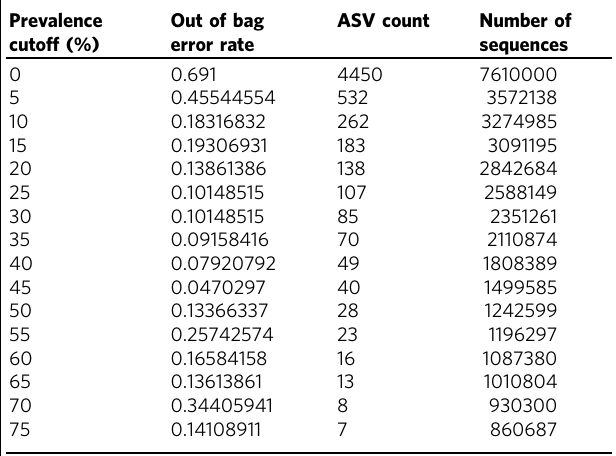
Table 3 Prevalence fi ltering focuses analysis on most shared ASVs